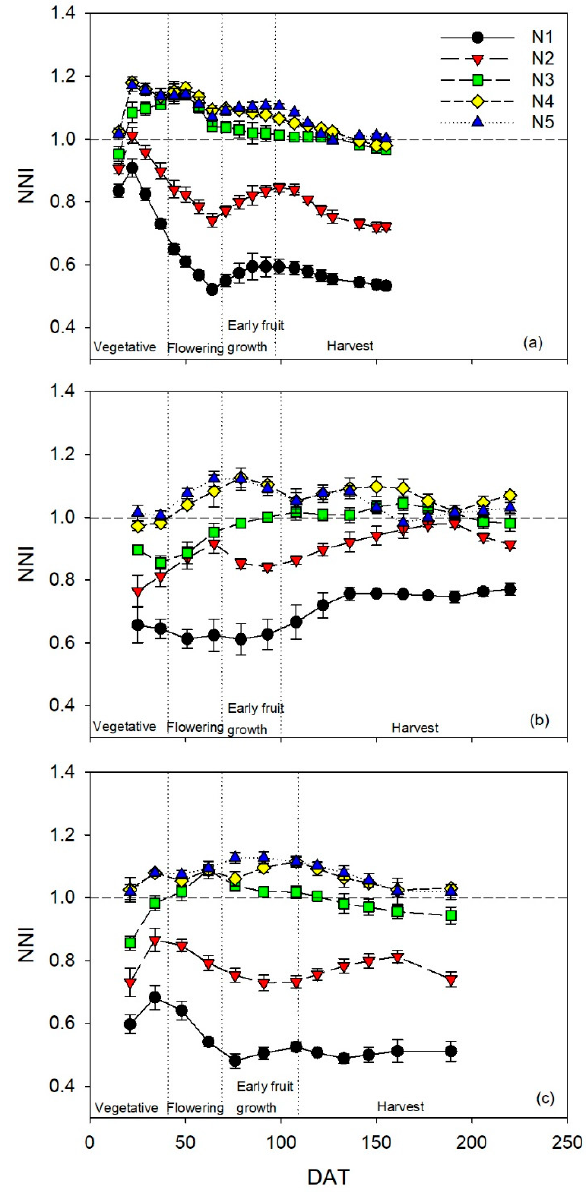
Figure 1. Temporal dynamics of the nitrogen nutrition index ( NNI ) for the sweet pepper ( Capsicum annuum ) crops in the ( a ) 2014, ( b ) 2016, and ( c ) 2017 crops, subjected to five di ff erent N treatments with four repetitions. Values are means ( n = 4) ± standard error ( ± SE). DAT is days after transplanting. Vertical dotted lines represent the di ff erent phenological stages; the horizontal dotted line indicates NNI = 1.